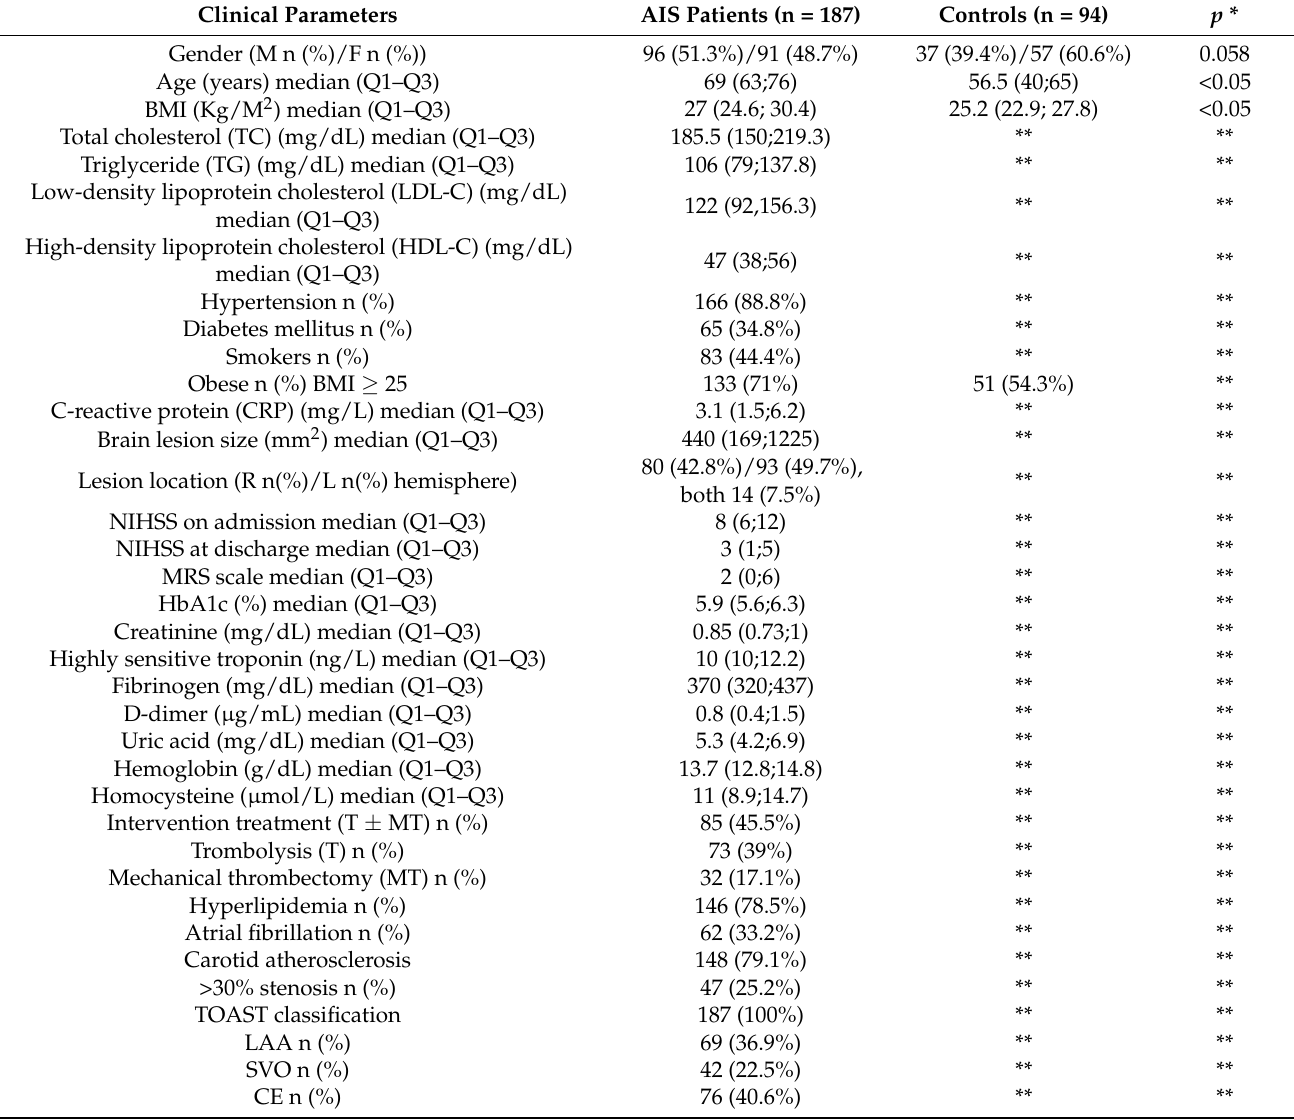
Table 1. Descriptive statistics for demographic data and biochemical values of study population. Clinical Parameters